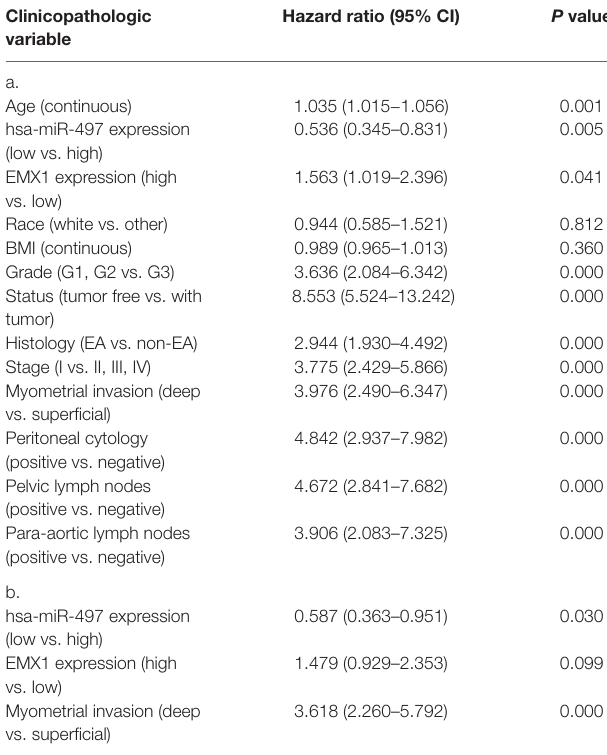
TABLE 5 | Univariate EMX1 expression* association with clinicopathologic characteristics (logistic regression). Clinicopathologic